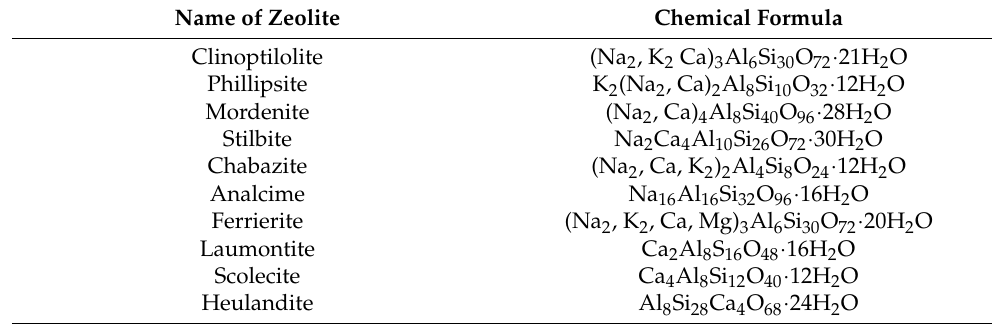
Table 2. Name and chemical formula of some natural zeolites. Reprinted with permission from Ref. [15]. Copyright 2010 Elsevier.